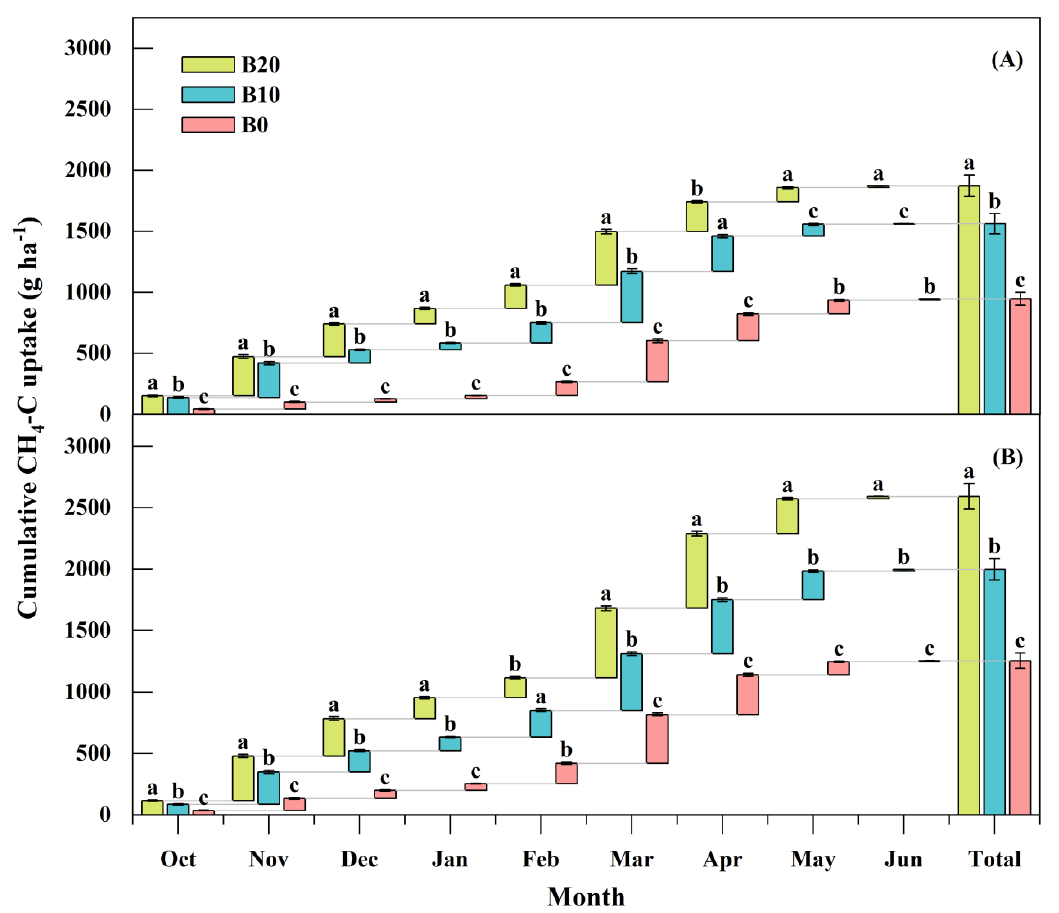
Figure 8. Cumulative CH 4 -C uptake under different amounts of added biochar during the winter wheat growing seasons in 2018–2019 ( A ) and 2020–2021 ( B ). Note: The column length represents the mean ± standard error of newly added cumulative CH 4 -C uptake in each stage, and different lowercase letters indicate significant differences between treatments (Duncan’s test, p < 0.05). Table 1. Equations of the relationships between the CO 2 -C emission fluxes (F) and soil water content (SWC) and soil temperature (ST) under different amounts of added biochar in wheat fields.